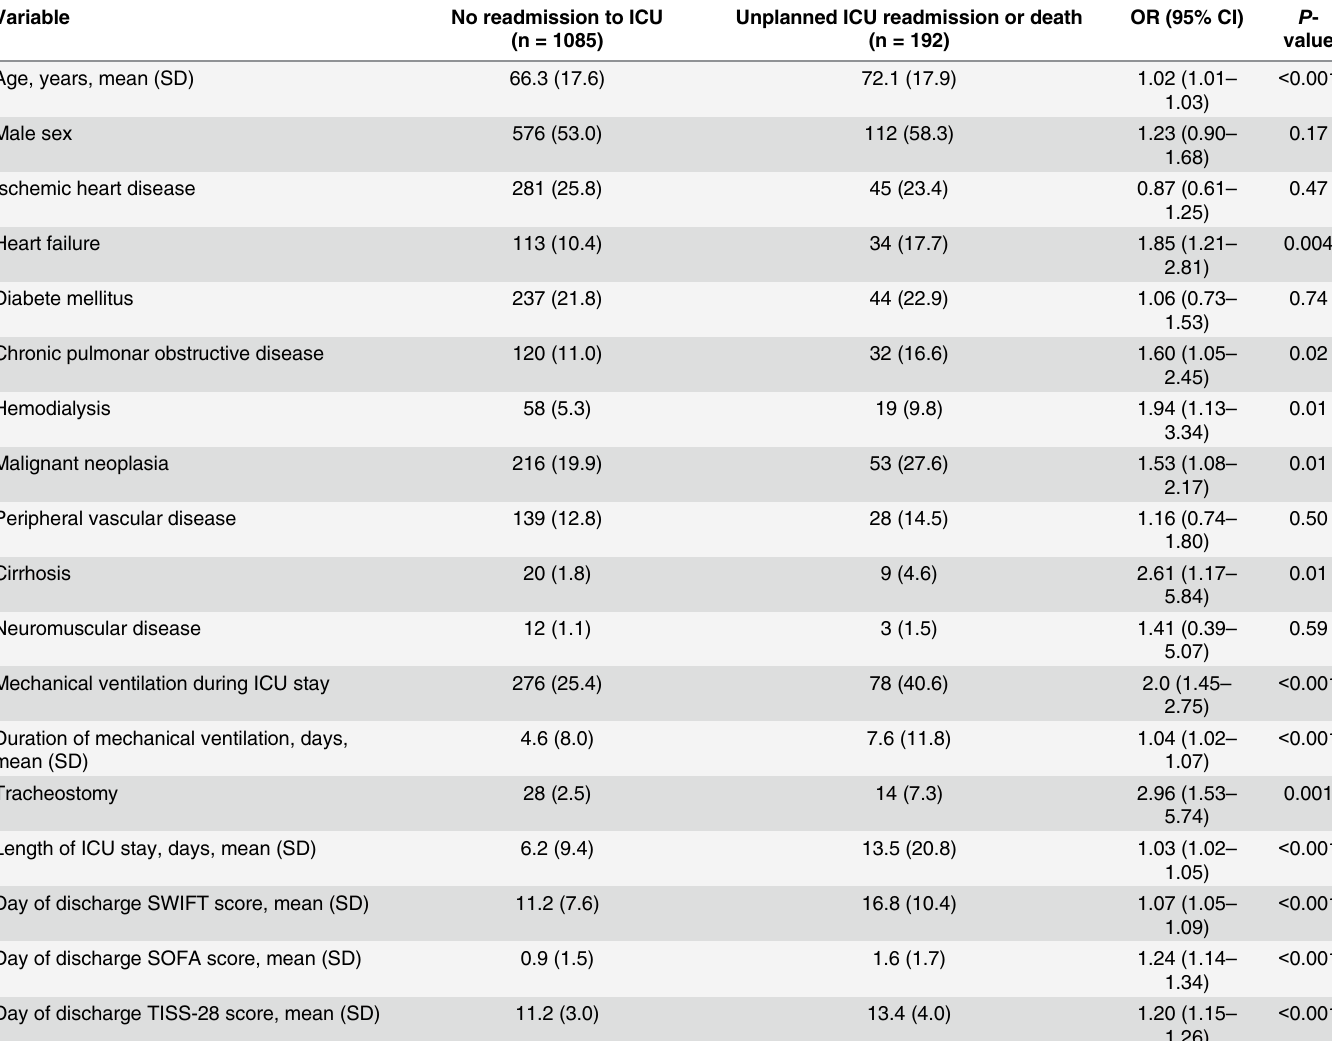
Table 5. Univariate logistic regression of factors associated with unplanned intensive care unit (ICU) readmission or death.